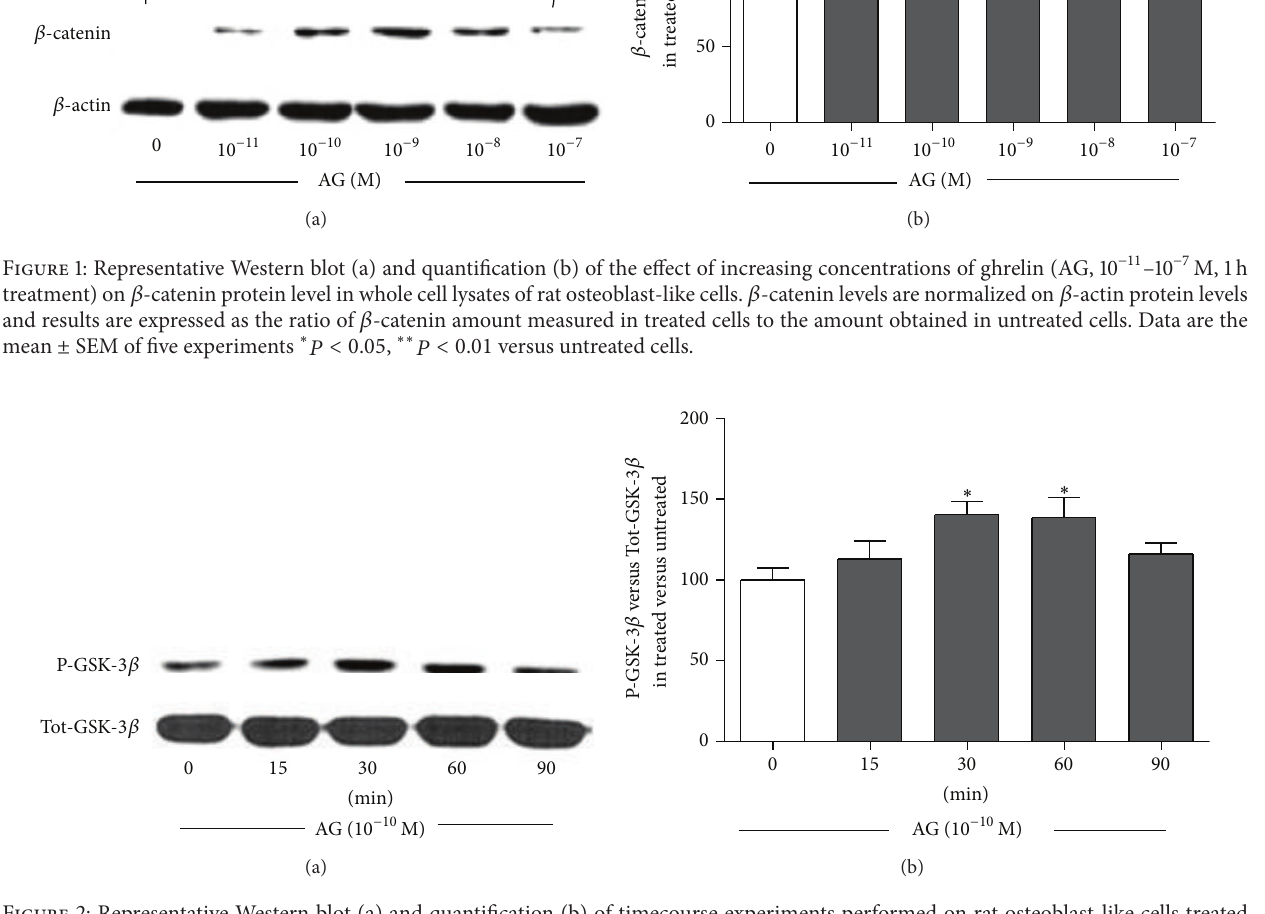
Figure 2: Representative Western blot (a) and quantification (b) of timecourse experiments performed on rat osteoblast-like cells treated with ghrelin (AG, 10 −10 M) for 15, 30, 60, and 90 min. Phosphorylated-GSK-3 𝛽 (P-GSK-3 𝛽 ) levels were measured in whole cell lysates and normalized to total GSK-3 𝛽 levels (Tot-GSK3 𝛽 ). Results are shown as ratio of P-GSK3 𝛽 measured in treated versus untreated cells. Data are the mean ± SEM of 5 experiments ∗ 𝑃 < 0.05 , versus untreated